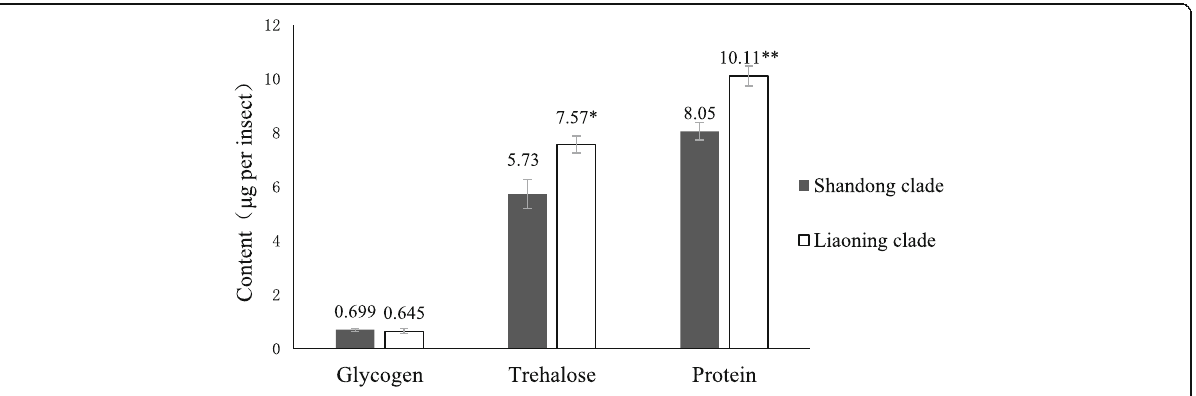
Fig. 3 Glycogen, trehalose, and protein levels of Aphelinus mali for two genetic clades found in